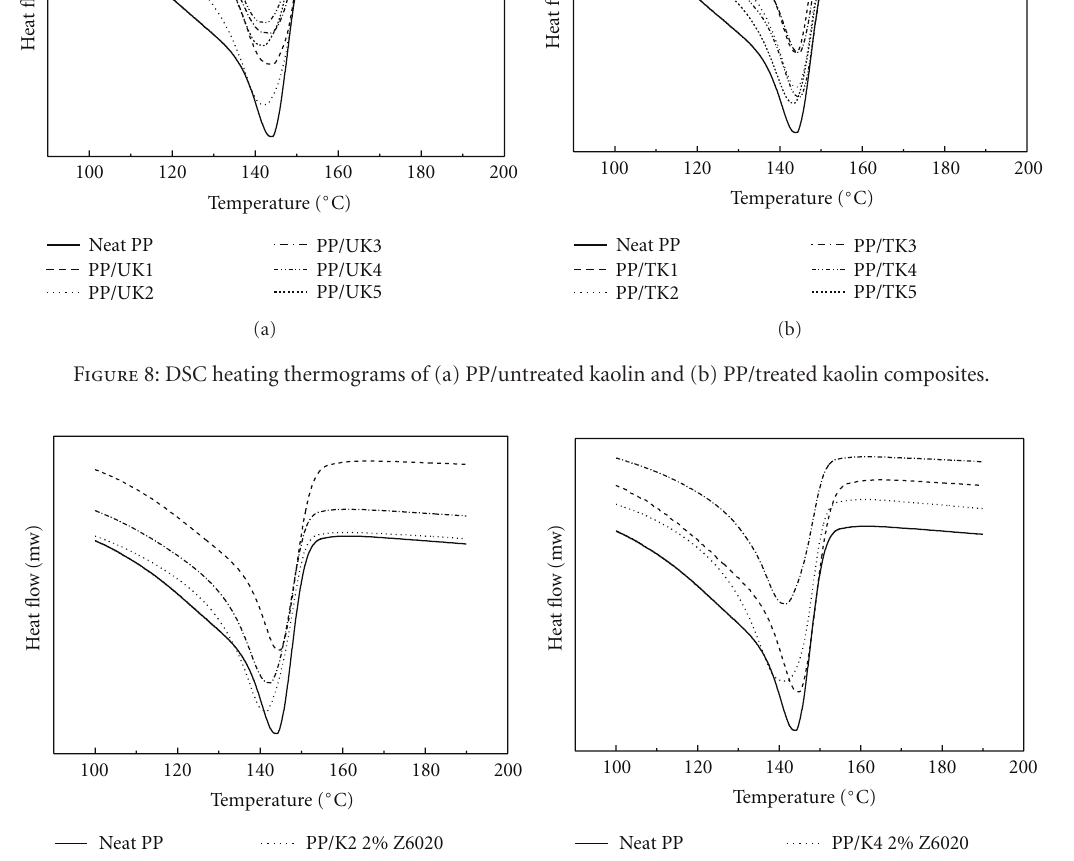
residual mass. The PP/untreated kaolin composites